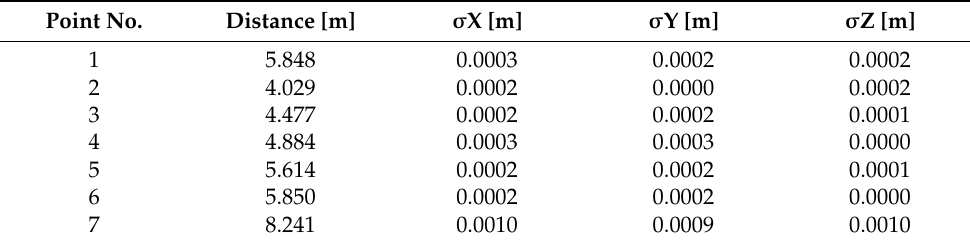
Table 1. Point positioning precision obtained with total station placed inside the housing. Point